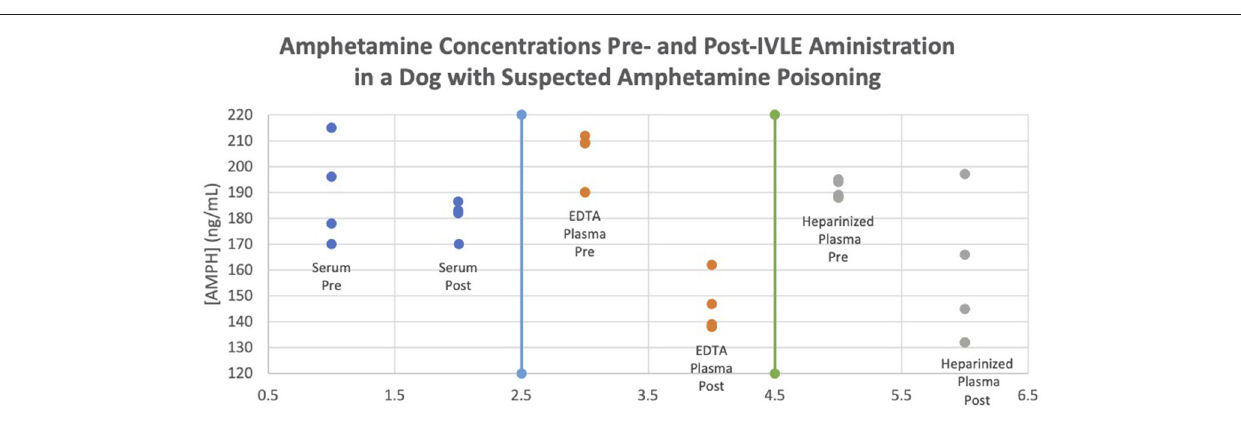
FIGURE 2 | Amphetamine concentrations pre- and post-IVLE administration in a dog with suspected amphetamine